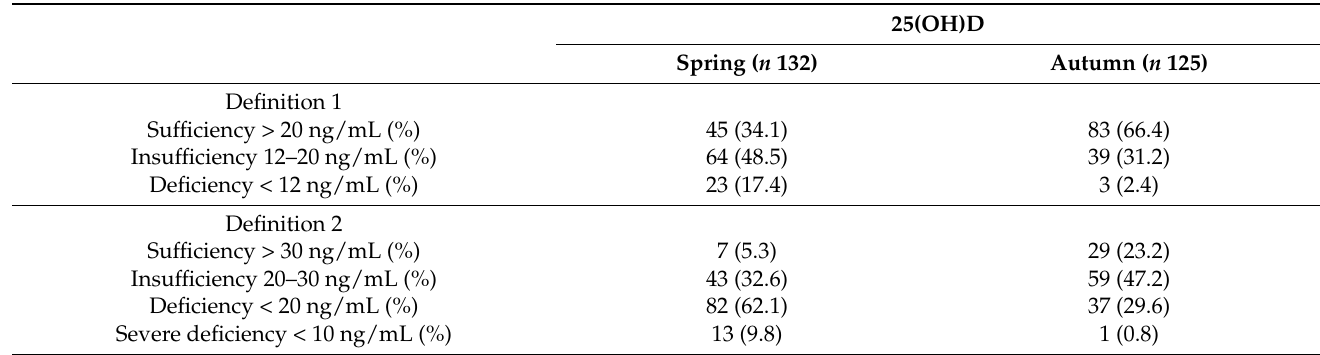
Table 1. Prevalence of vitamin D sufficiency, insufficiency, deficiency, and severe deficiency depending on the accepted cut-offs for spring vs. autumn, p < 0.001, chi 2 test.